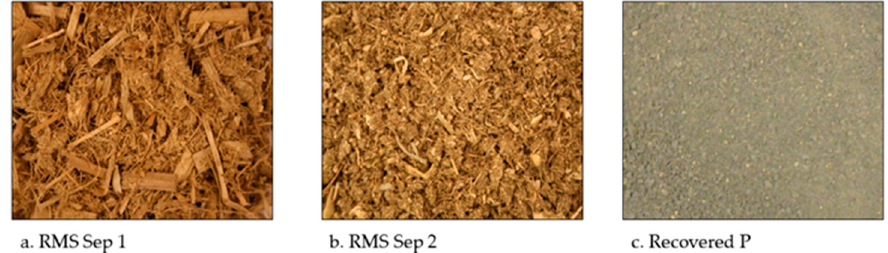
Figure 5. Recovered manure solids (RMS) from Sep 1 (>12.7 mm), Sep 2 (12.5 mm–0.25 mm), and recovered phosphate material (>0.25 mm).